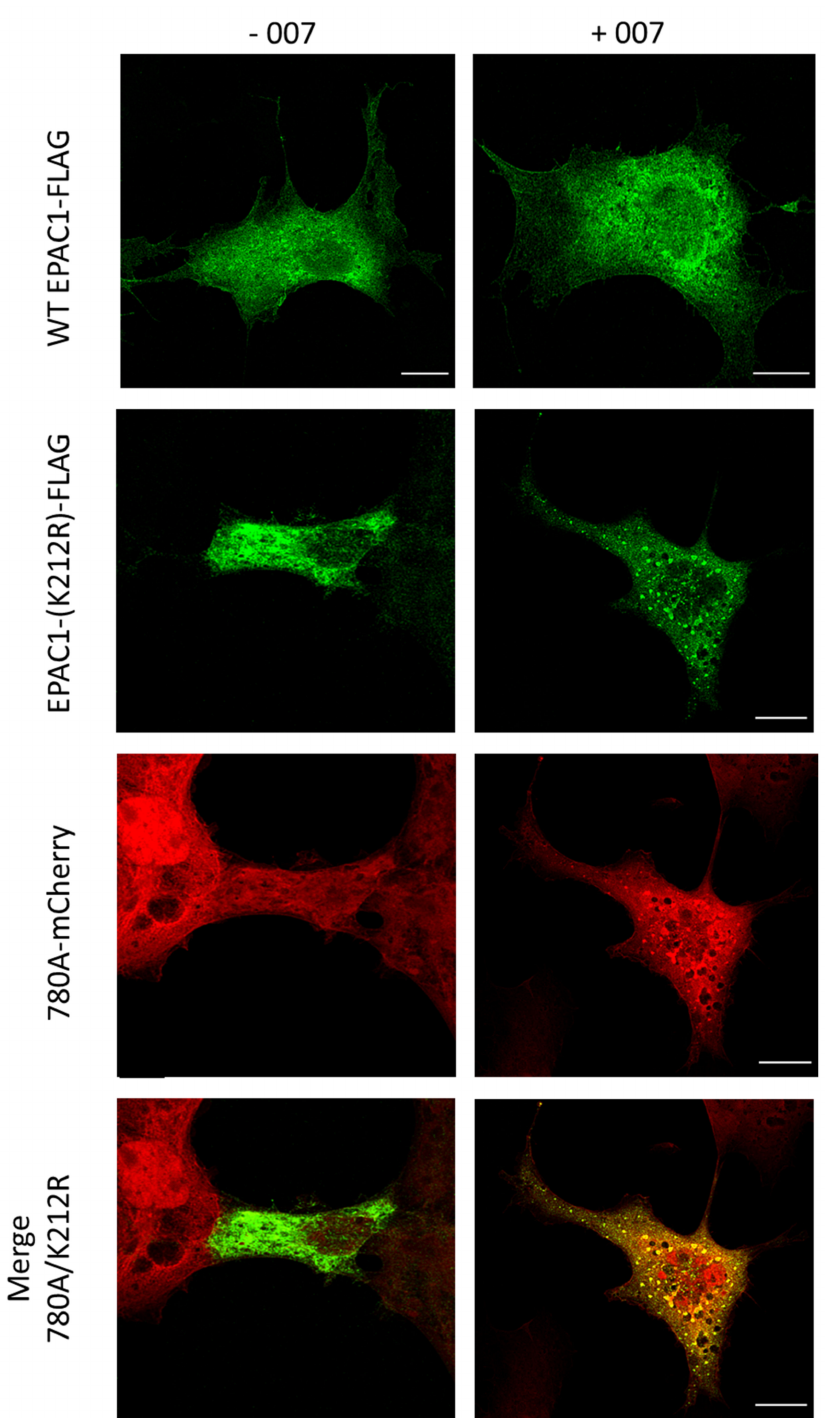
Figure 10. Localization of Affimer 780A-mCherry with co-transfected wild-type and mutant (K212R) EPAC1 in COS1 cells. COS1 cells were transiently co-transfected with 780A-mCherry and WT-EPAC1-FLAG or EPAC1-(K212R)-FLAG 780A-mCherry and then stimulated ± 100 µ M of 007 for 15 min (37 ◦ C, 5% ( v/v ) CO 2 ). Following fixation, permeabilization and blocking cells were then incubated for one hour each with α -FLAG and goat α -mouse IgG (Alexa Fluor 488 conjugated) primary and secondary antibodies, respectively. Coverslips were then mounted onto glass slides using Prolong™ Glass Antifade Mountant and analyzed on a Leica TCS SP8 STED 3X confocal microscope with a Leica HC PL APO C52 63 × water objective. Samples were excited using a Supercontinuum White laser at 488 and 580 nm for Alexa Fluor 488 and mCherry proteins, respectively, and were detected using a Leica HyD hybrid detector with detection windows of 500–550 nm (Alexa Fluor 488) and 590–650 nm (mCherry). Scale bar: 100